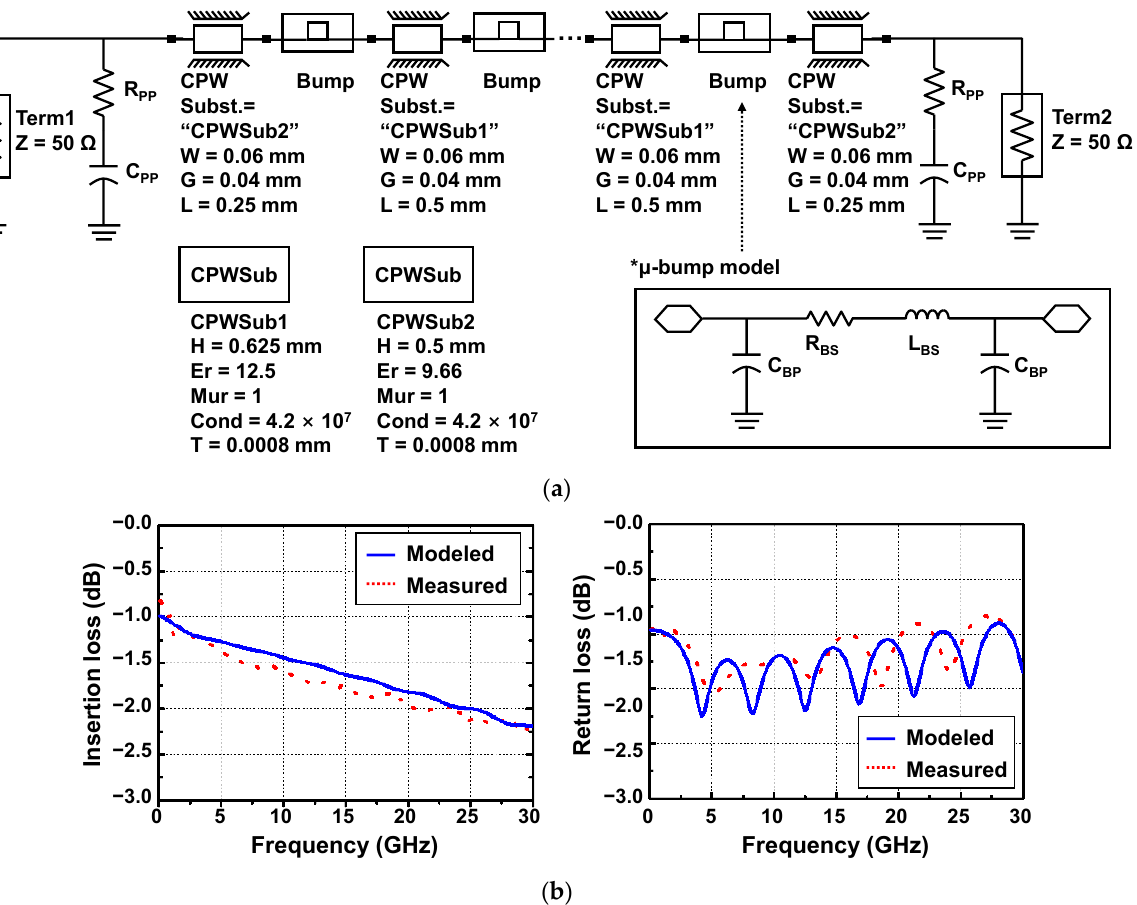
Figure 11. RF modeling of flip-chip-bonded InP-to-SiC CPW lines: ( a ) equivalent circuit diagram for RF modeling of CPW lines; ( b ) measured and modeled S-parameter results for a CPW line with 10 daisy chains.